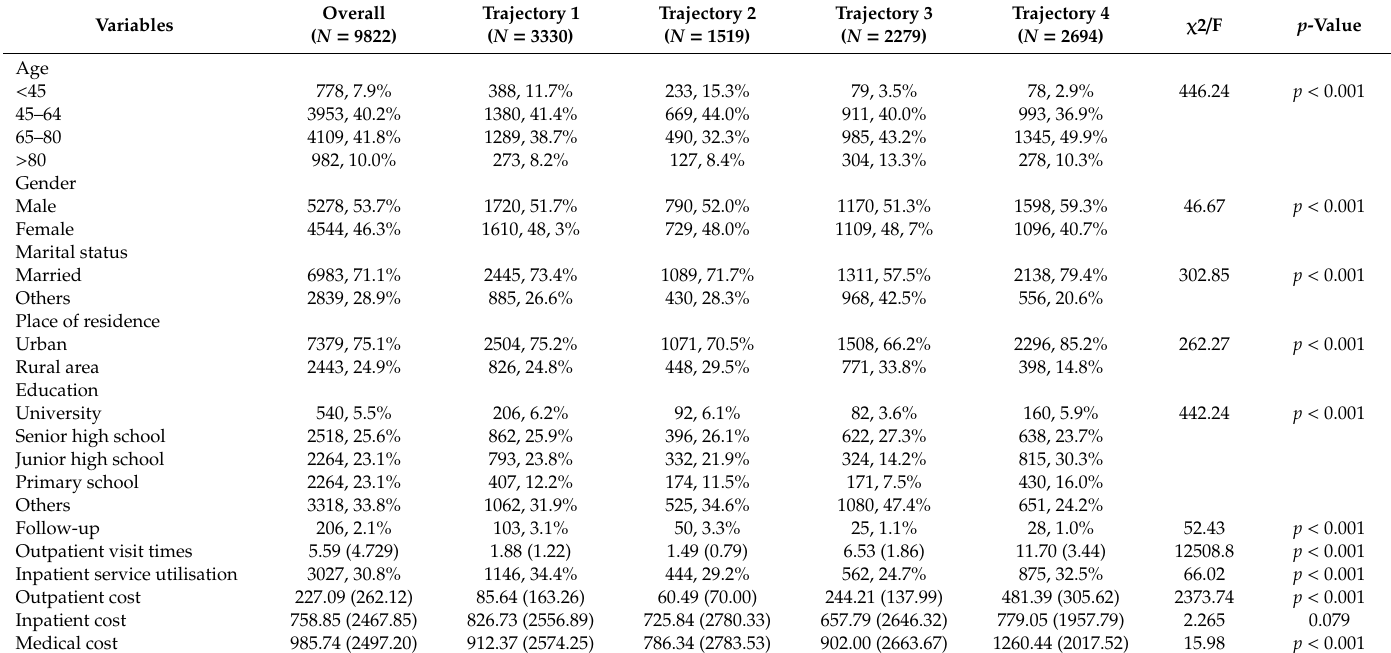
Table 1. Demographic characteristics by hypertension patient outpatient service utilisation